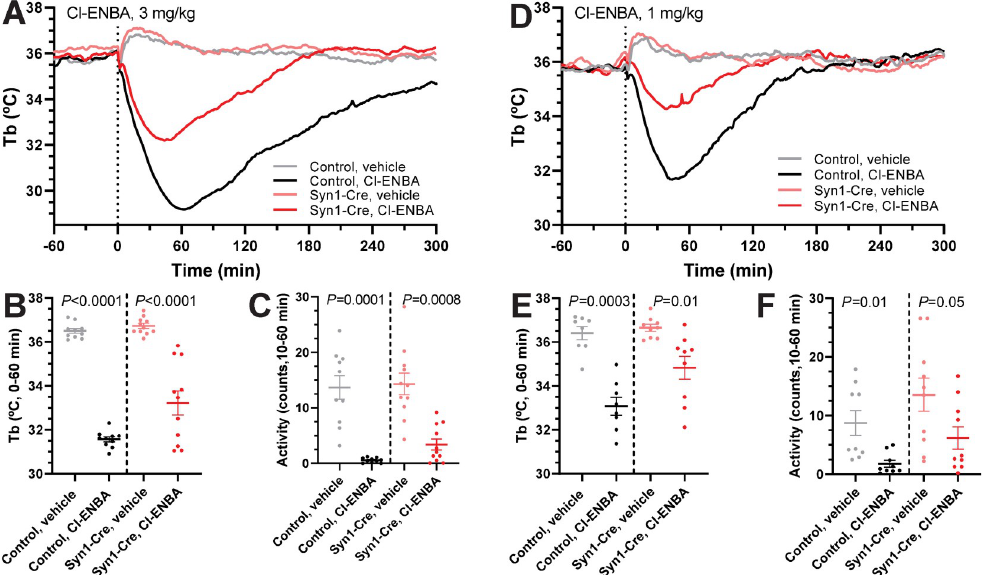
Fig 2. Neuronal A 1 AR partially mediate Cl-ENBA induced hypothermia. (A-C) Core body temperature (Tb) and physical activity response to Cl-ENBA (3 mg/kg, i.p.) or vehicle in Adora1 fl (n = 10) and Adora1 fl ;Syn1-Cre (n = 11) mice. (D-F) Tb and physical activity response to Cl-ENBA (1 mg/kg, i.p.) or vehicle in Adora1 fl (n = 8) and Adora1 fl ;Syn1-Cre (n = 9) mice. Data are mean ± SEM (SEM is omitted for visual clarity in A and D). P values calculated by paired t -test comparing drug vs vehicle within